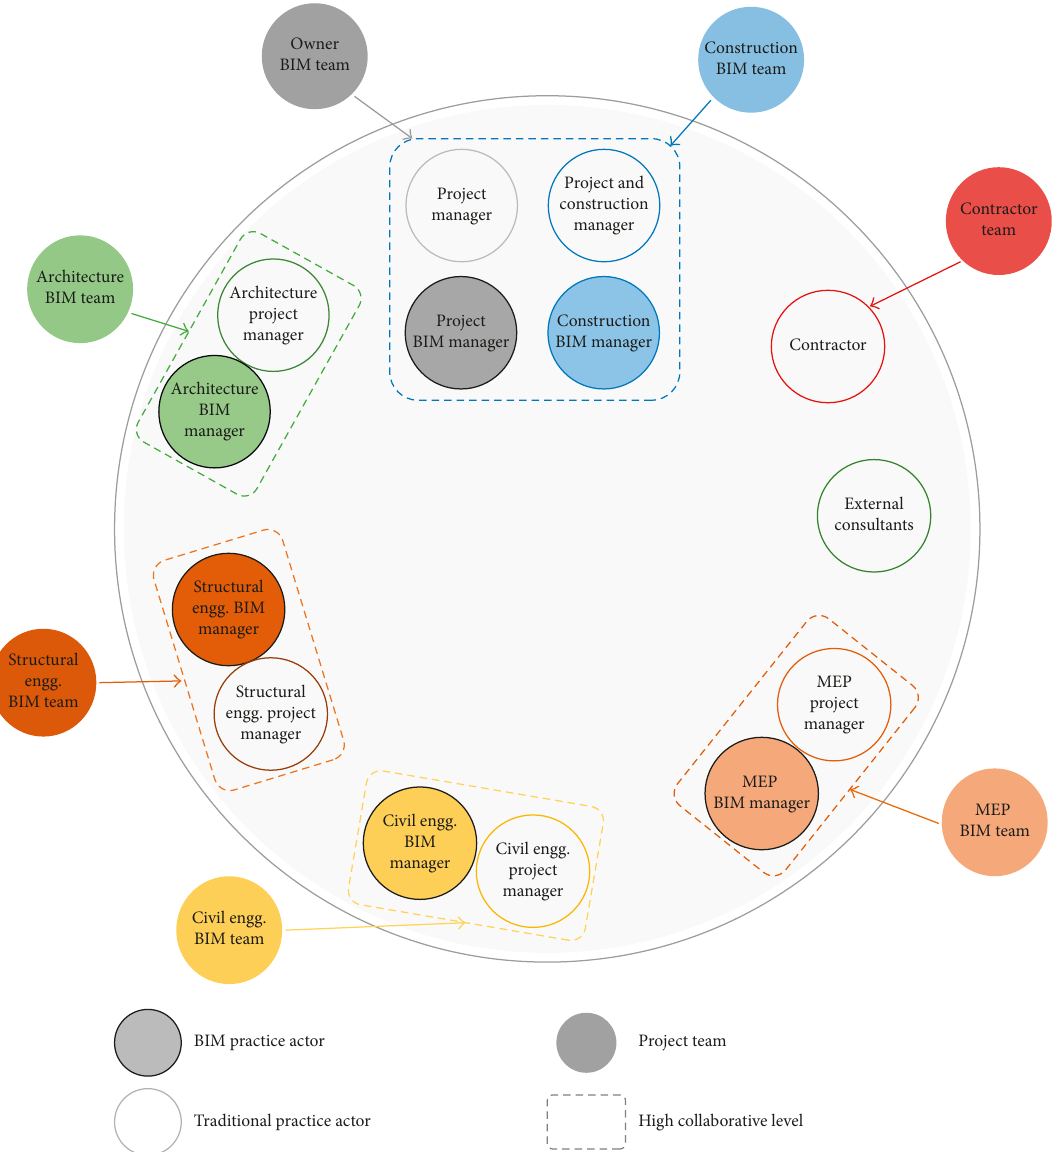
Figure 3: Managerial roles in the project (source: Project